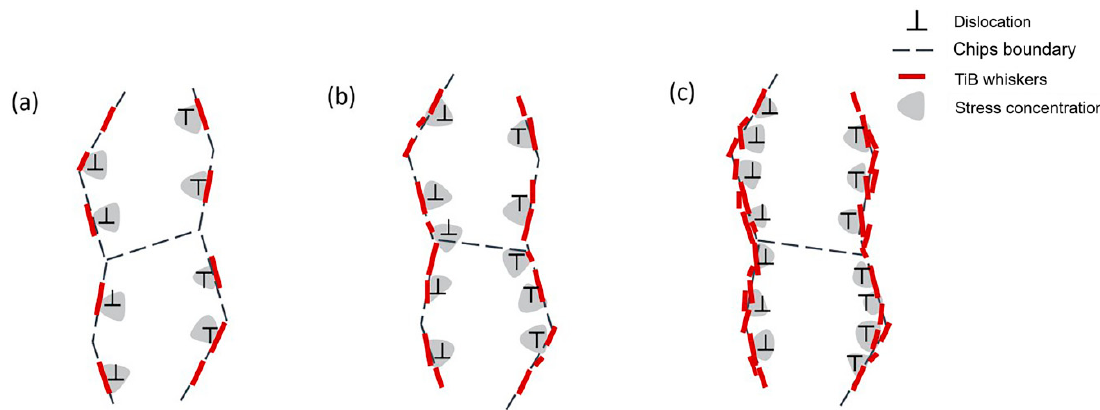
Figure 13. Schematic illustrations of dislocation mechanisms in ( a ) discontinuous TiB reinforcement layers; ( b ) quasi-continuous TiB reinforcement layers; and ( c ) continuous TiB reinforcement layers.